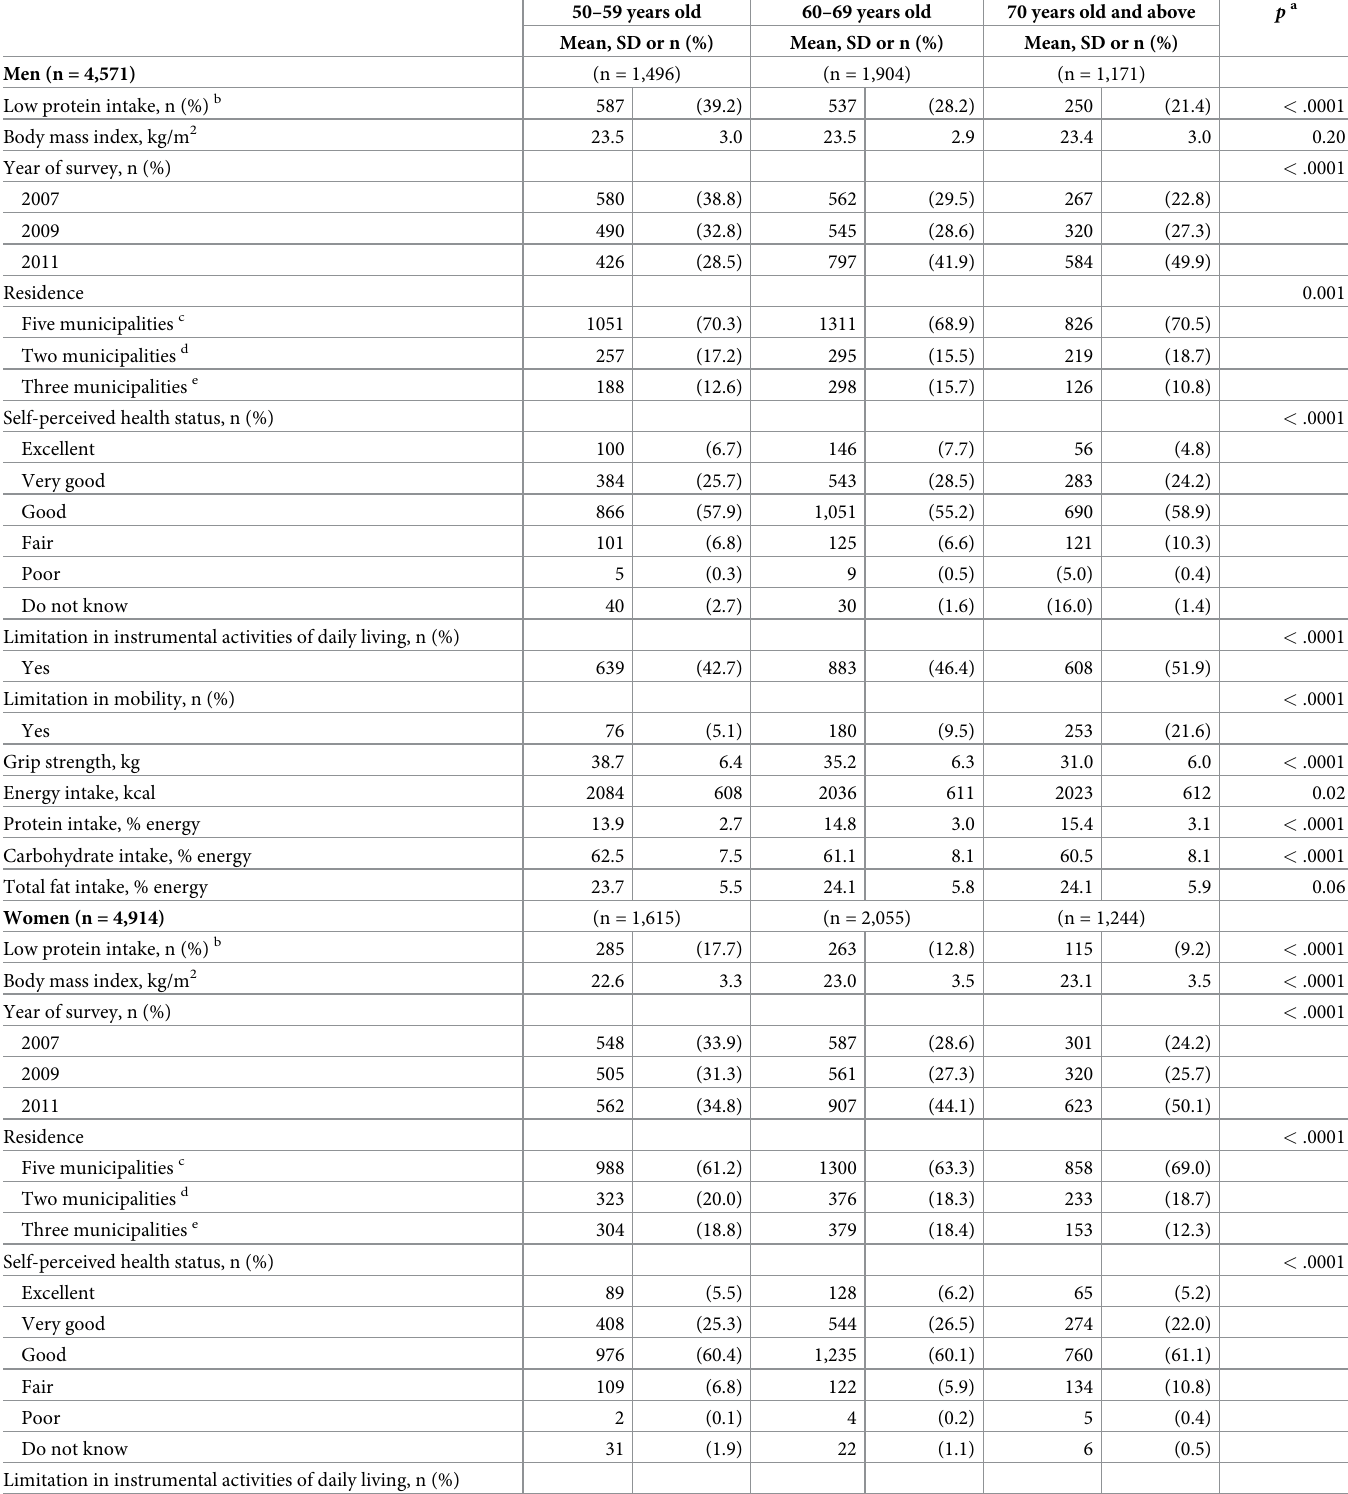
Table 1. Baseline characteristics of the study